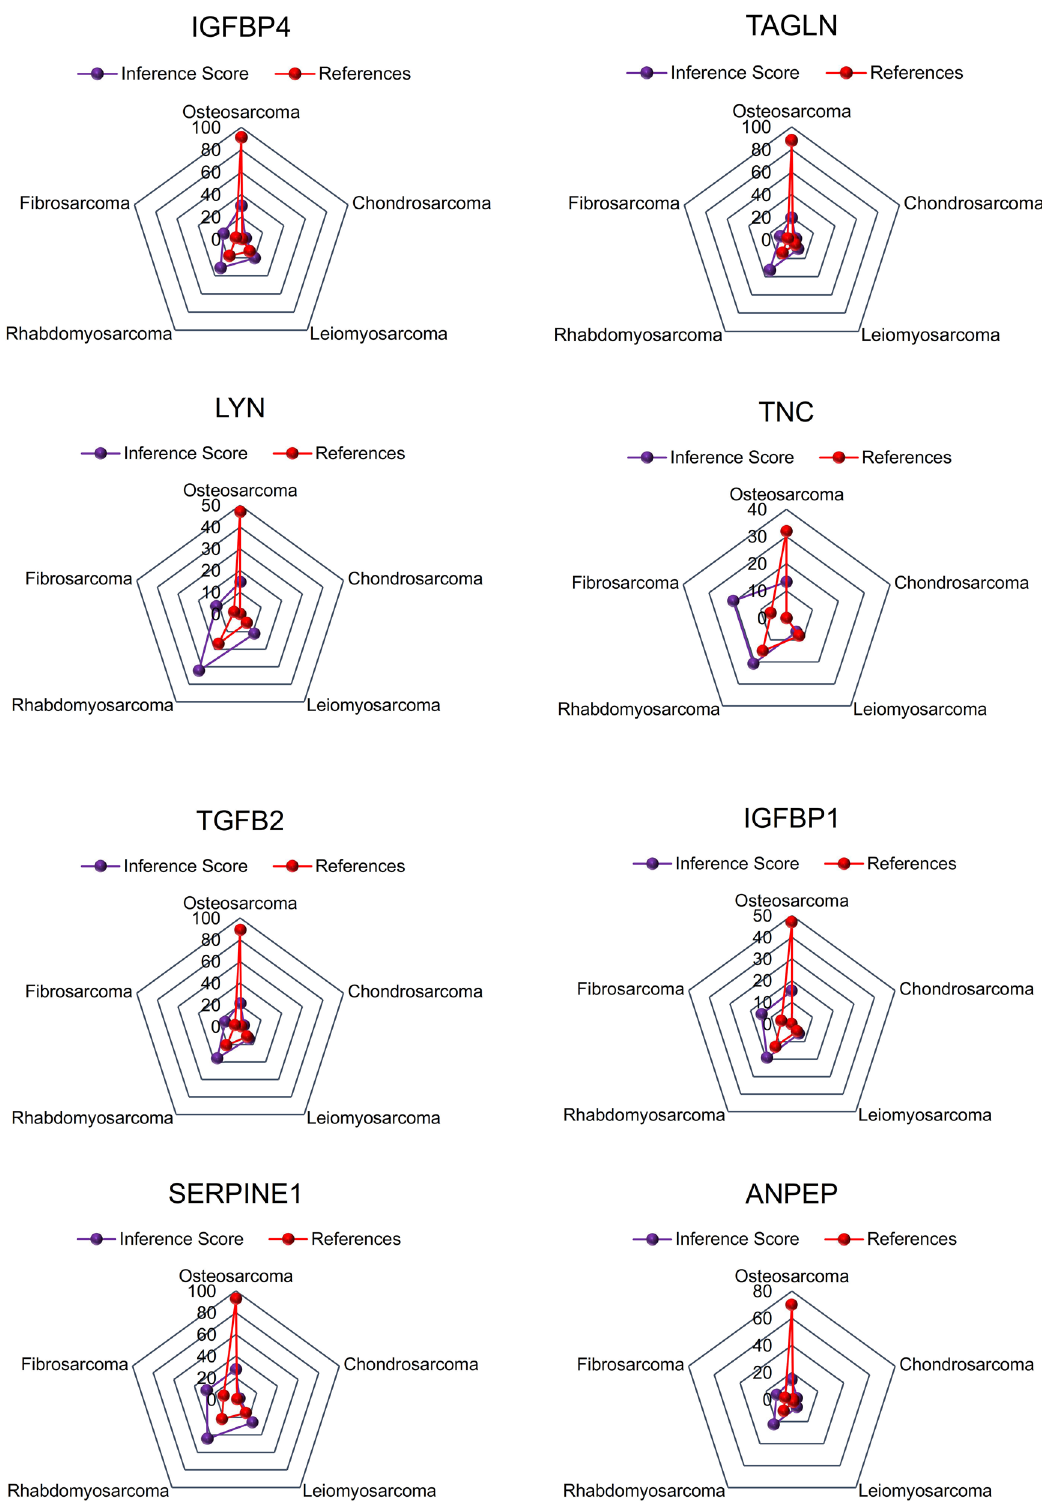
Figure 6. Identification of inference score of hub genes in the osteosarcoma by the CTD